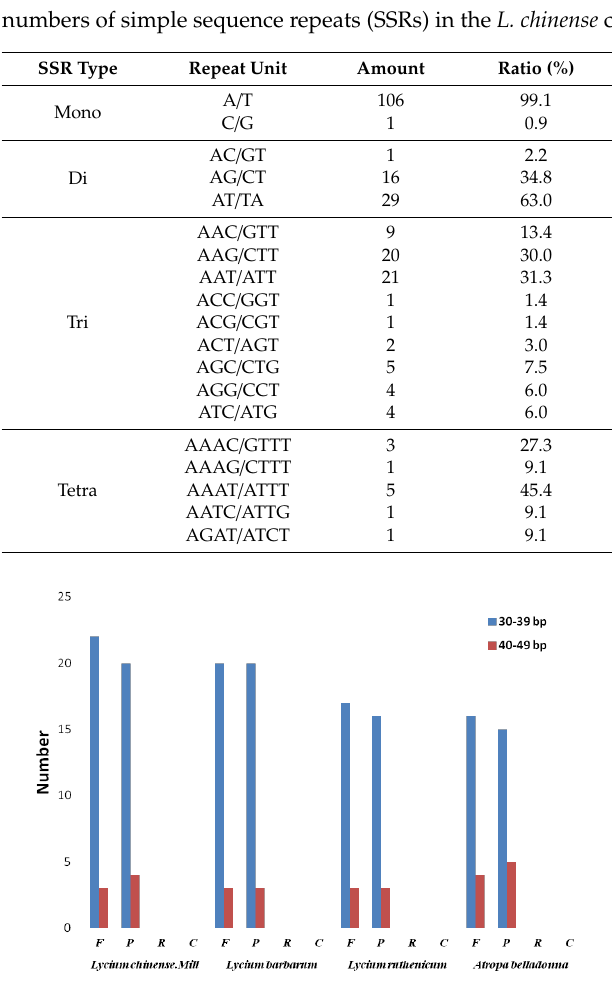
Figure 2. Repeat sequences in four chloroplast genomes. F, forward, P, palindrome, R, reverse, and C, complement, respectively. Colors represent repeats of different lengths, as